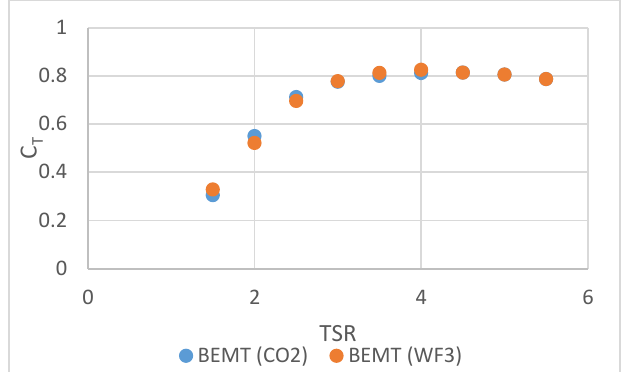
Figure 9. C T comparison between BEMT calculations for the 1.0 m/s case during “current only” conditions and when the turbine operates under wave-current interactions with a wave height of approximately 0.4m and an apparent wave period of 1.5s IV. P OWER C OEFFICIENTS AND LOADS FOR NON - UNIFORM